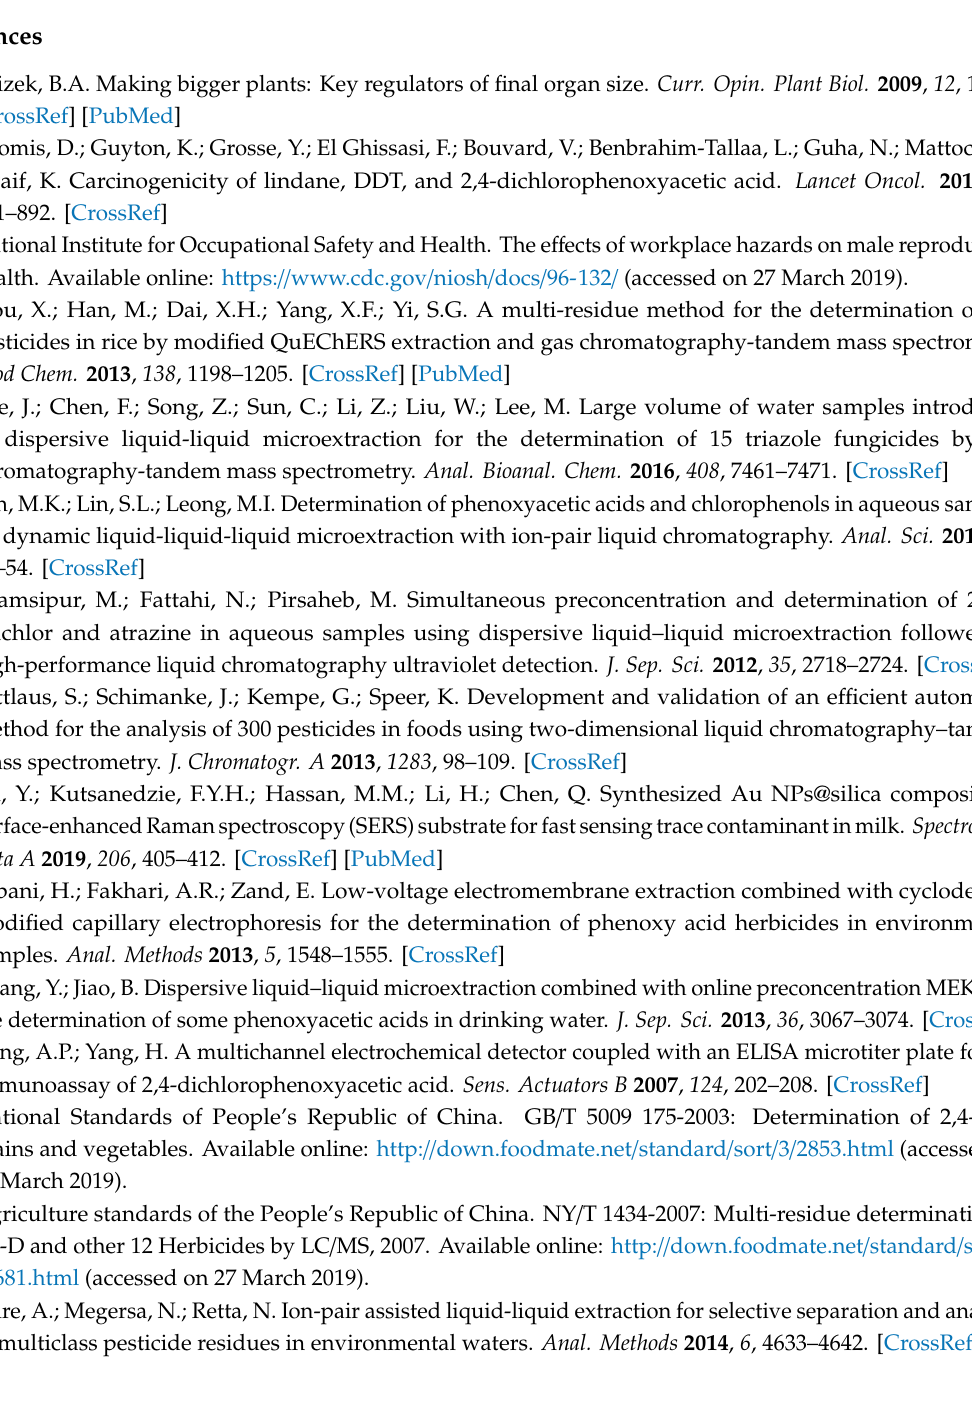
Supplementary Materials: The following are available online: Figure S1: Pore size distribution profile of the poly (OMA-co-TRIM) monolith by the mercury intrusion method; Figure S2: The peak area of 2,4-D after several operation cycles; Figure S3: Construction of the online hydrophobic in-tube SPME-HPLC system. Author Contributions: Preparation and characterization of the monolithic column, W.L. and F.W.; optimization for the online hydrophobic in-tube SPME, W.L. and B.N.; rice cultivation, Y.D.; sample preparation, J.Z. and